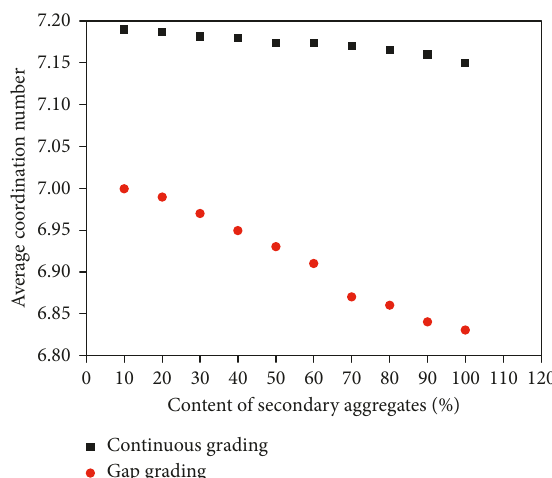
Figure 21: Variation of the average coordination number with the content of the secondary aggregates.